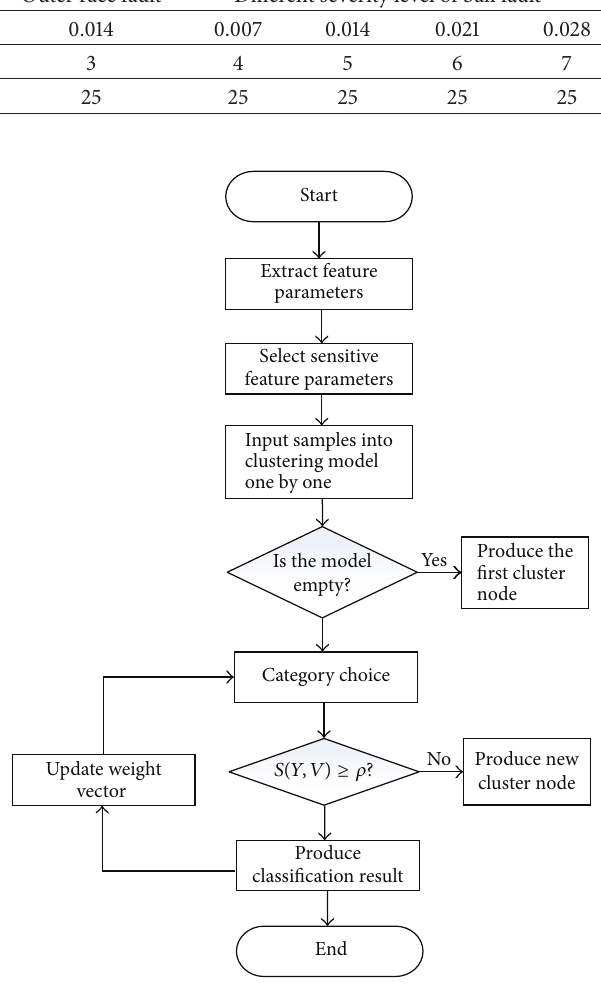
Figure 4: Fault diagnosis flowchart of the proposed method.